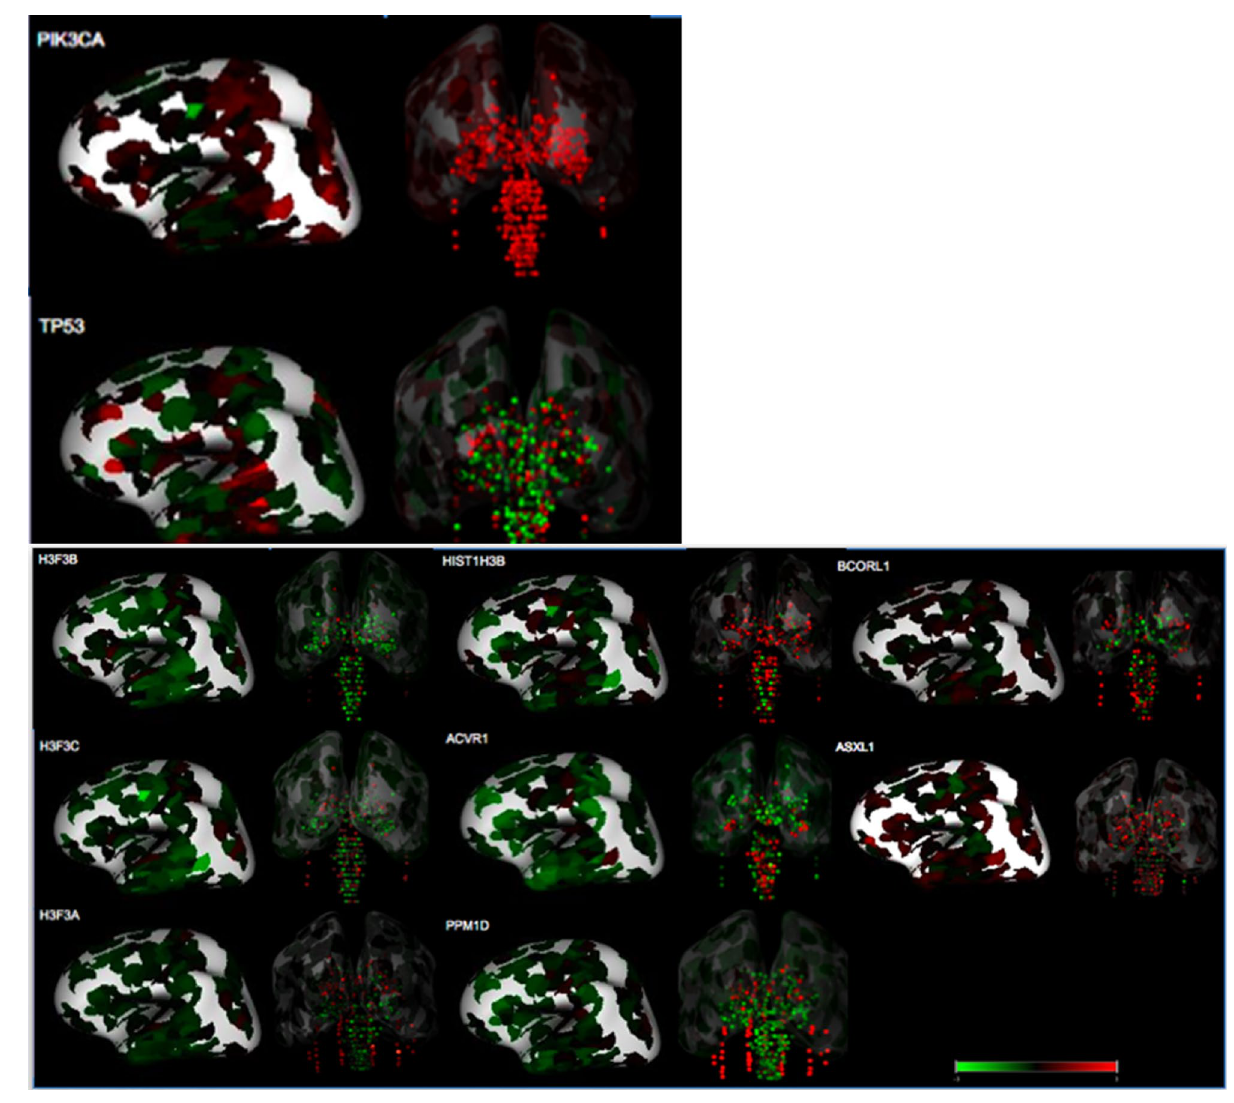
Figure 1. Location based human gene expression levels within the cerebral hemispheres and along the midline structures for H3F3A, H3F3B, H3F3C, HIST1H3B, ACVR1, PPM1D, BCORL1, and ASXL1. Distribution of gene expression z scores within the brain with green indicating low expression and red indicating high